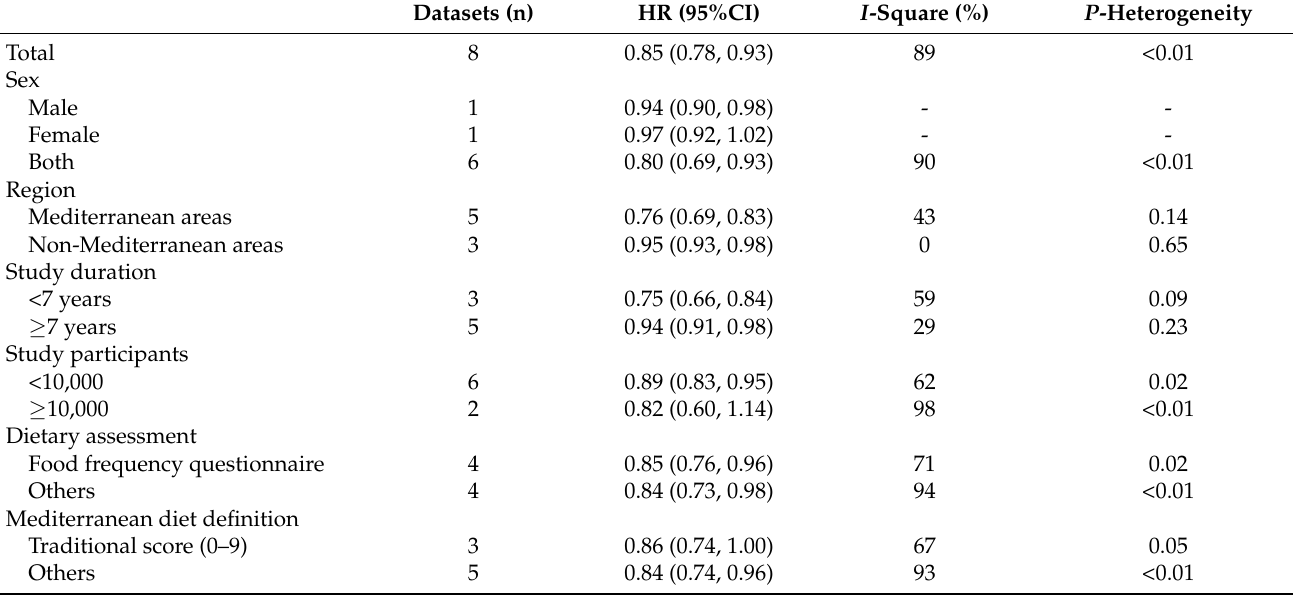
Table 2. Subgroup analyses of included